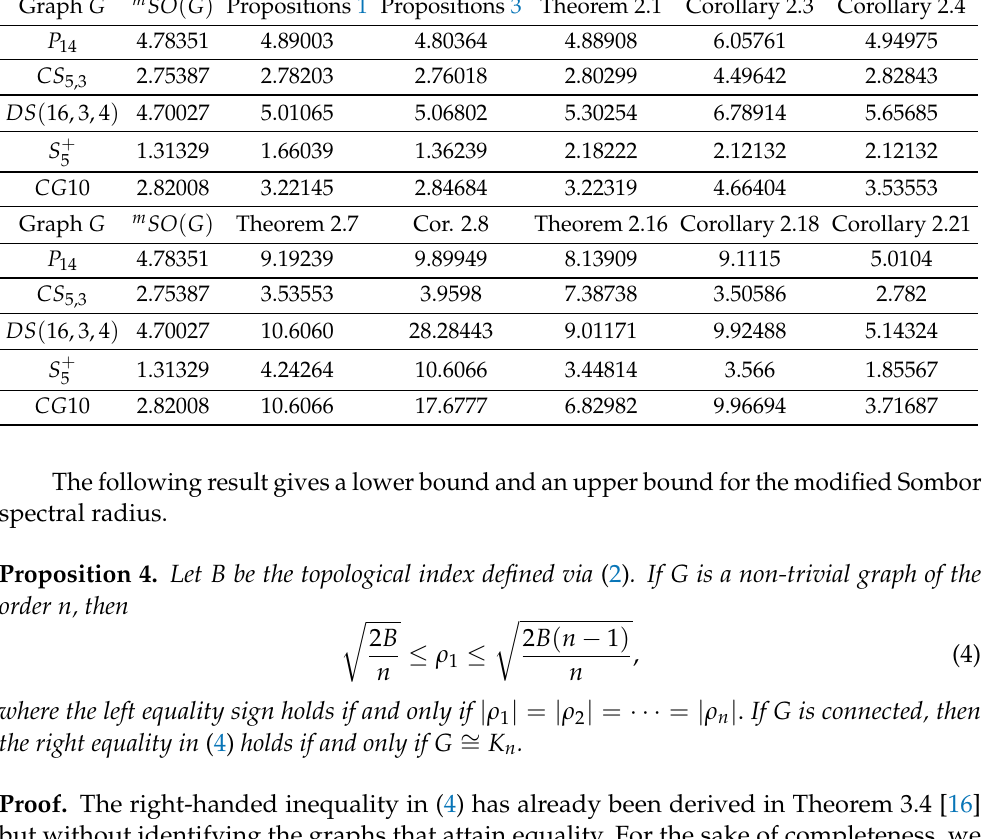
Table 1. Table showing value of modified Sombor index for some graphs, numerical values of the bounds obtained in Propositions 1 and 3, and the different results of Huang and Liu [16]. Graph